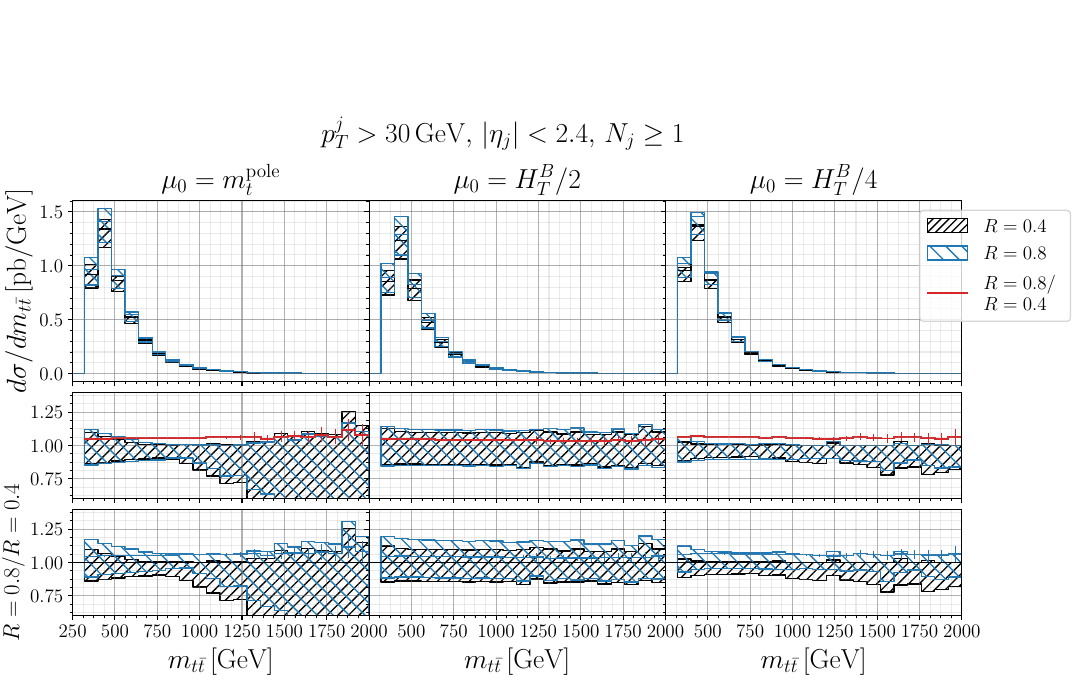
Figure 30 . Same as figure 27, but for the m